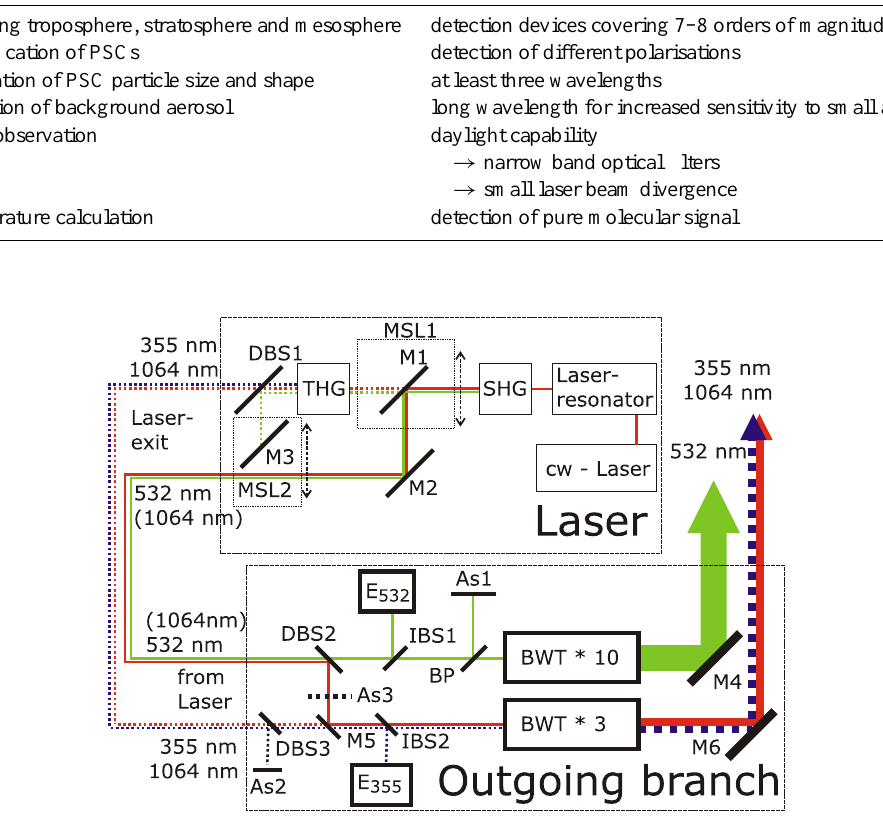
Fig. 1. Optical setup of the transmitter branch in 2- λ mode (solid lines) and 3- λ mode (dashed lines). See text for